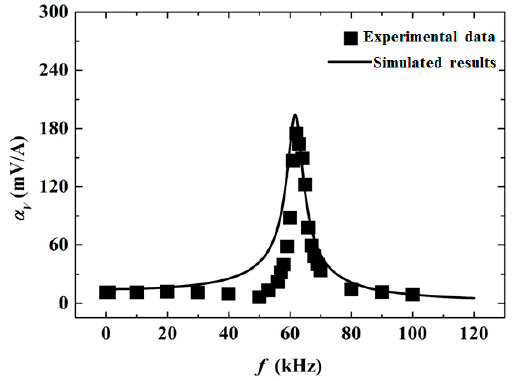
Figure 3. A comparison of the results of the theoretical calculations from the proposed method and the experimental measurements for the ME laminate ring.